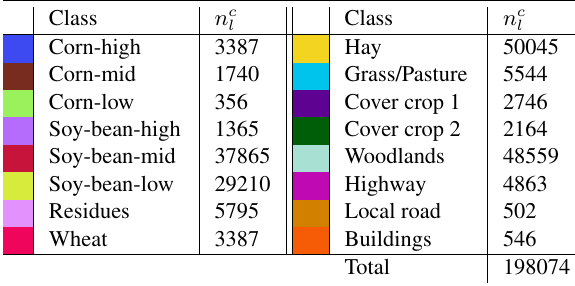
) of the ground truth of the l